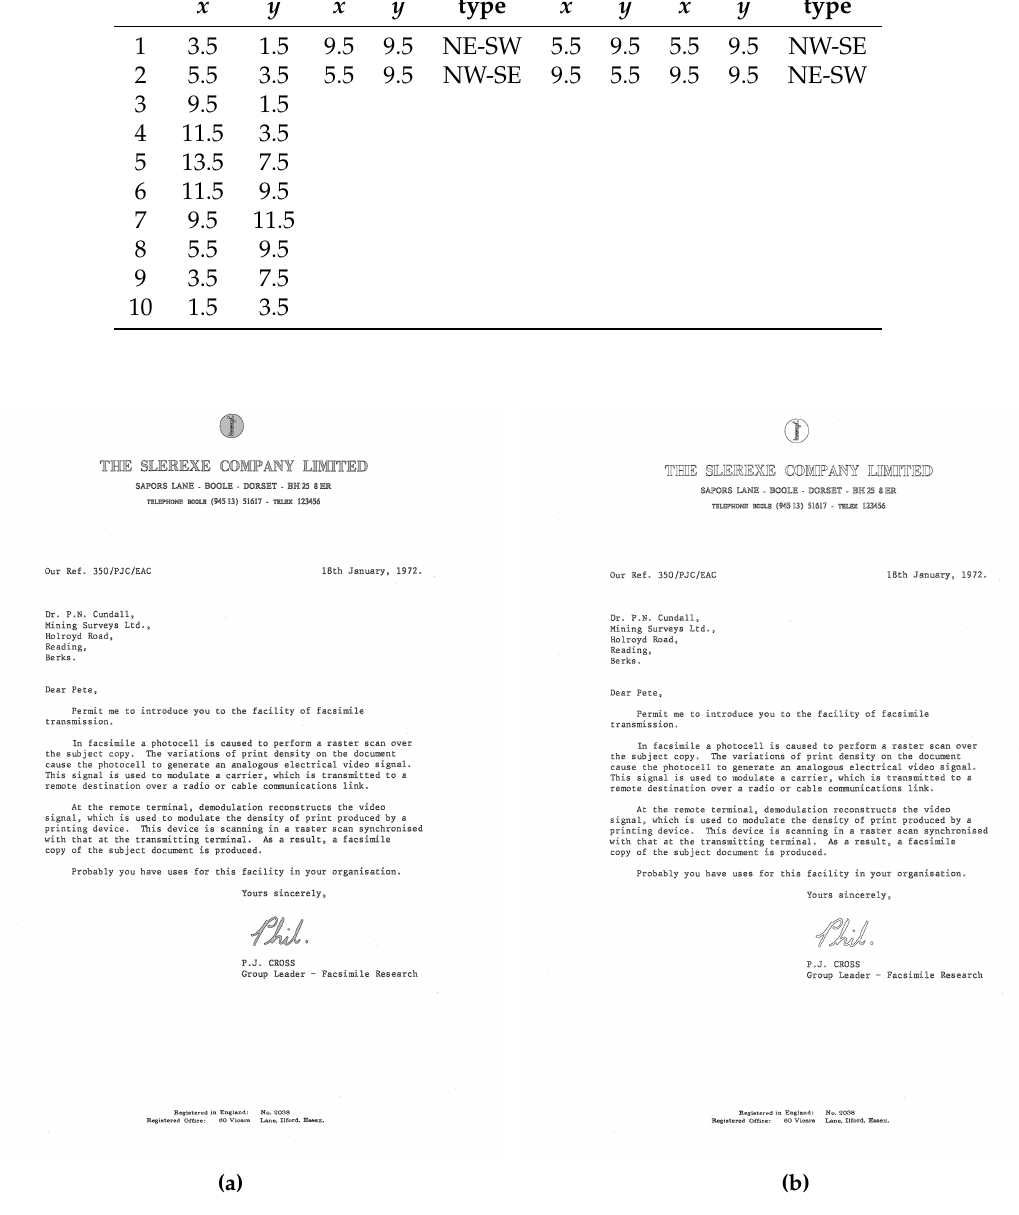
Figure 20. Result of the experiment for CCITT #1. Contour pixels are shown in black, original image pixels in grey. ( a ) Result of contour tracing; ( b ) result of contour